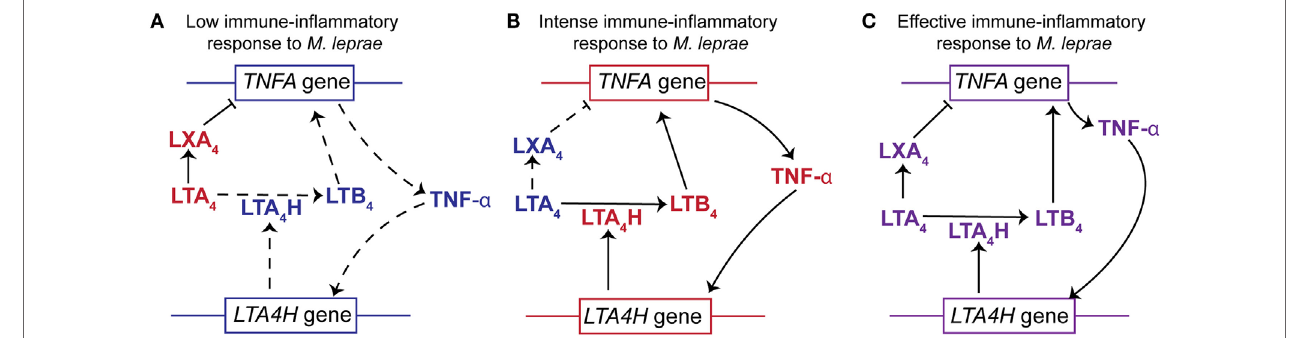
FigURe 4 | The relationships between LTA4H gene polymorphisms, the LXA 4 /LTB 4 ratios and TNF- α production to the outcome of Mycobacterium leprae infection. (A) Individuals homozygous for LTA4H locus with two low activity alleles display a higher concentration of LXA 4 than LTB 4 (high LXA 4 /LTB 4 ratio). This would impair the production of TNF- α resulting in increased susceptibility to M. leprae . The higher levels of LXA 4 not only inhibit the expression of TNFA but also block the immune-inflammatory responses. In addition, the lower levels of TNF- α do not stimulate the expression of LTA4H and therefore do not increase the synthesis of LTB 4 . (B) Subjects homozygous for LTA4H locus with two high activity alleles display a higher concentration of LTB 4 than LXA 4 (low LXA 4 /LTB 4 ratio). The increased abundance of LTB 4 stimulates the expression of TNFA and production of TNF- α . Increased levels of TNF- α further enhance expression of LTA4H . Thus, an intense immune-inflammatory response to M. leprae would occur resulting in damage to the host tissue. (C) Individuals heterozygous for LTA4H locus, with a high and a low activity allele, synthesize a balanced amount of LXA 4 and LTB 4 (moderated LXA 4 /LTB 4 ). This results in the production of TNF- α to levels that promote an effective immune-inflammatory response against M. leprae and promote a balance in the LXA 4 /LTB 4 ratio. This balance in product abundance or gene expression is represented by the purple font. The red font represents an increased abundance of a product or increased gene expression, while the blue font symbolizes an attenuation of product abundance or gene expression. Arrows with solid lines indicate that the production of a lipid mediator or cytokine is favored, while an arrow with a hashed line indicates that the production is not favored. ( ⊢ )Indicates that LXA 4 attenuates or impairs the expression of TNF- α